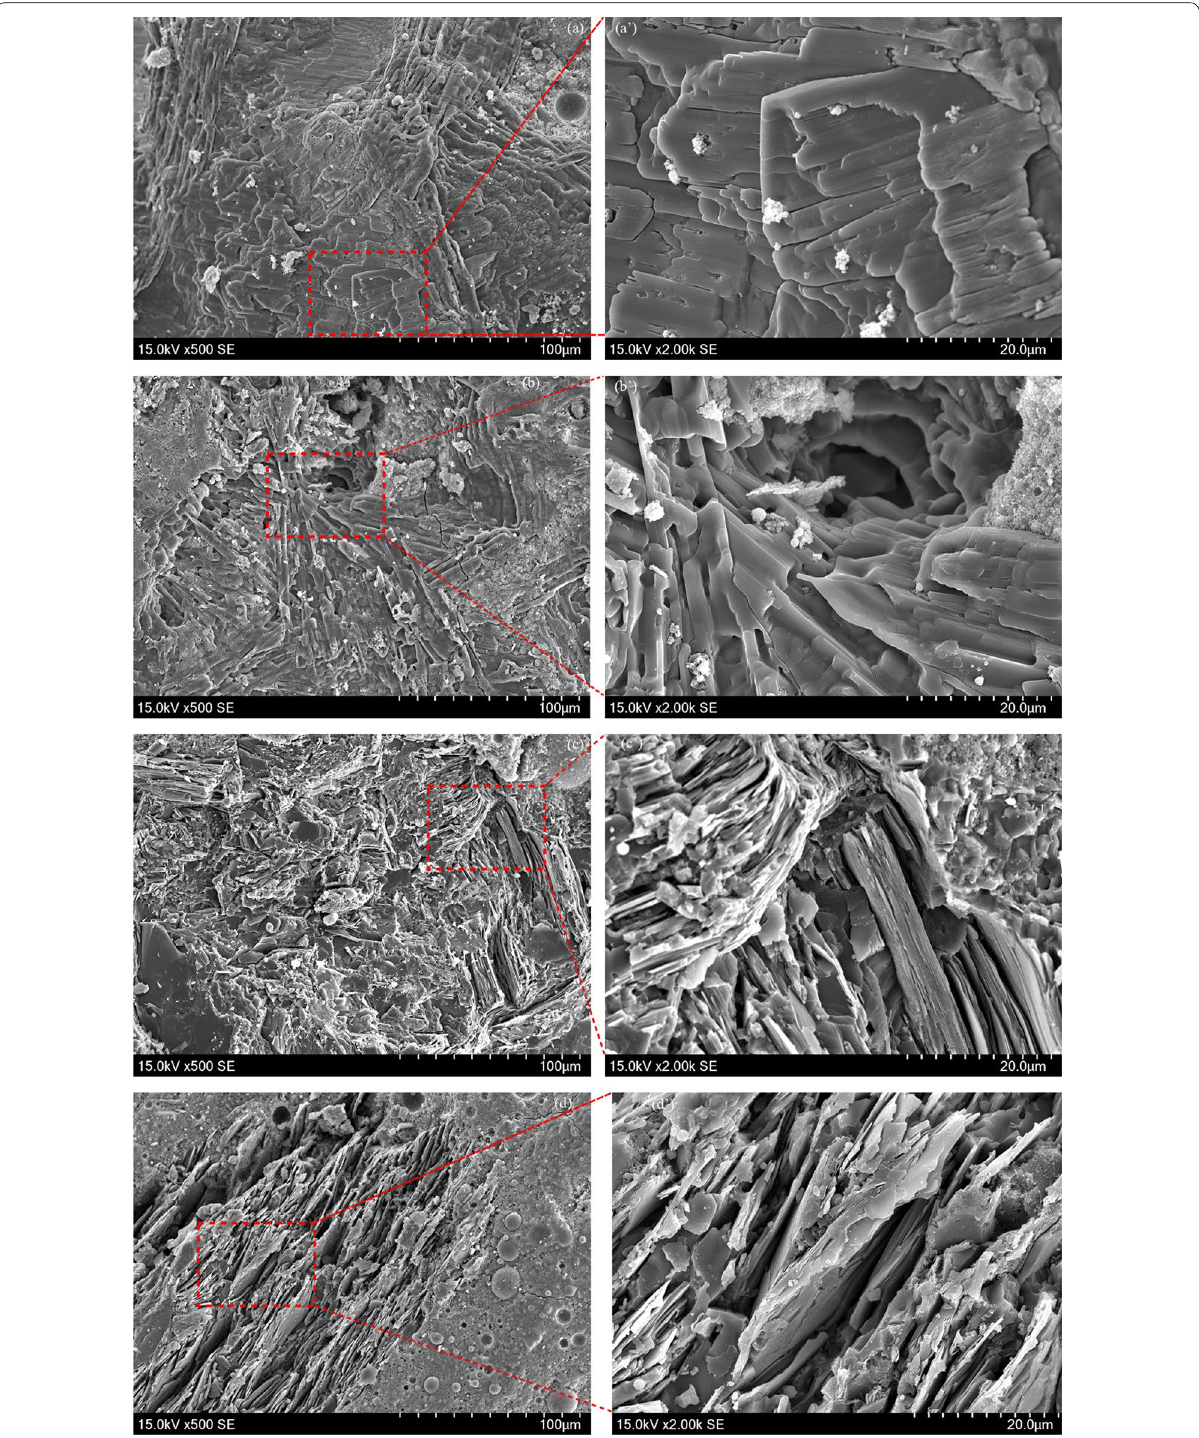
Fig. 8 SEM images of FAGC samples at 480 days ( a – d corresponding to